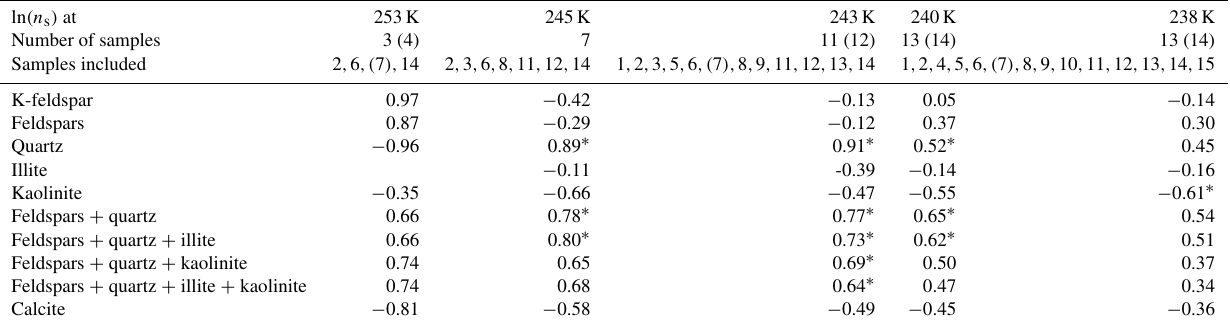
Table 5. Overview of the Pearson correlation coefficients of the sum of selected mineral fractions and ln (n s ) at different temperatures. The names of the included sample numbers can be found in Tables 1 and 4. At 253K only four samples were measured. At T ≤ 245K only samples with FF between 0.1 and 0.9 were included for the correlations. The Etosha sample (7) was only included in the correlation with calcite because it does not contain feldspars, illite, or kaolinite and only traces of quartz. An asterisk indicates that the correlation was significant at the 0.05 level. ln (n s ) at 253K 245K 243K 240K 238K Number of samples 3